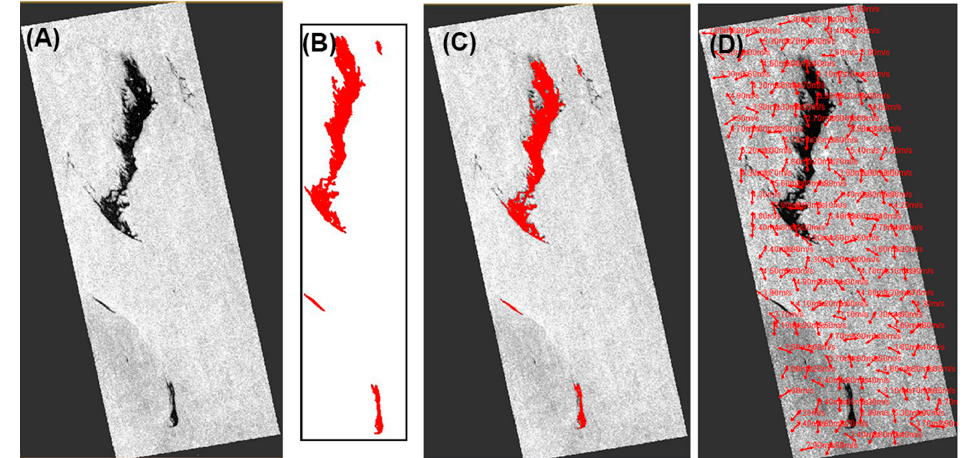
Figure 5. Oil spill clustering using a background window size of 500 pixels and a threshold shift of 3.5 dB and wind vector calculations ( A ) = raw data; ( B ) = clustered oil spill; ( C ) = superimpose of the clustered oil spillover raw data, and; ( D ) = superimposed by wind vector